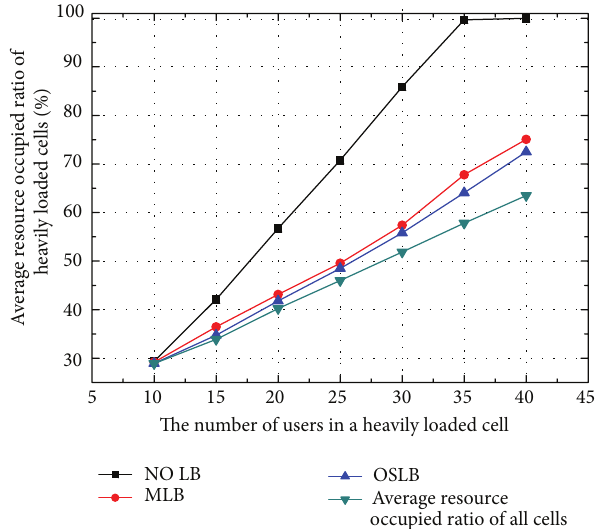
Figure 11: The average resource occupied ratio of heavily loaded cells versus the number of users in a heavily loaded cell.